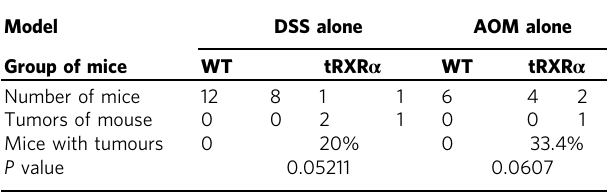
Table 1 Transgenic expression of tRXR α promotes colorectal carcinogenesis